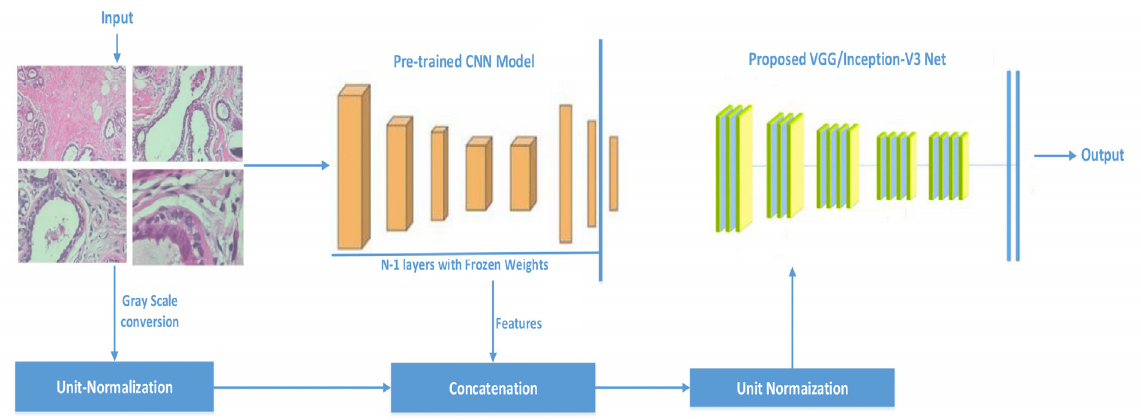
Figure 1. Proposed framework based on transform learning; the given image is passed to the pre-trained network and features are extracted, later, that feature is concatenated with the same image which is vectorized by unit normalization.